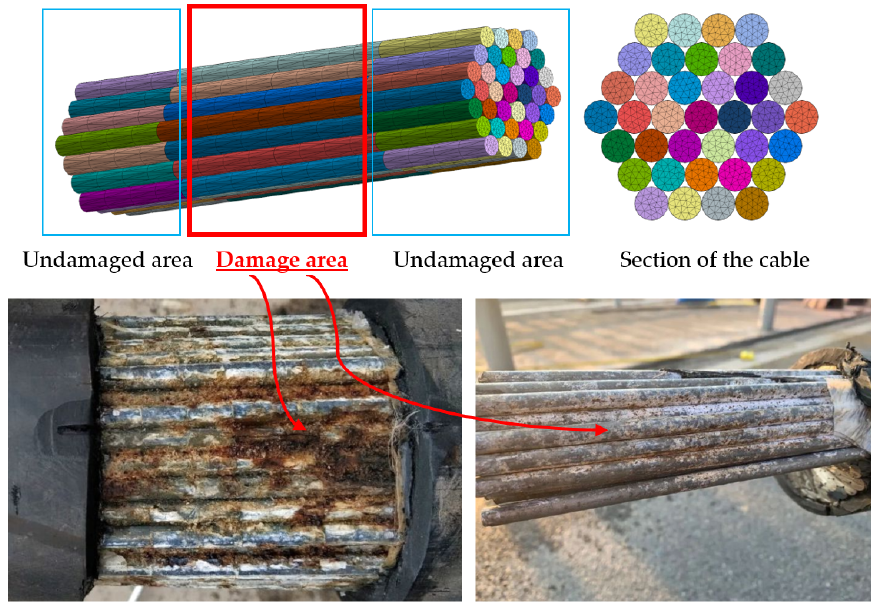
Figure 4. Photo of corrosion damage to the cable strand.